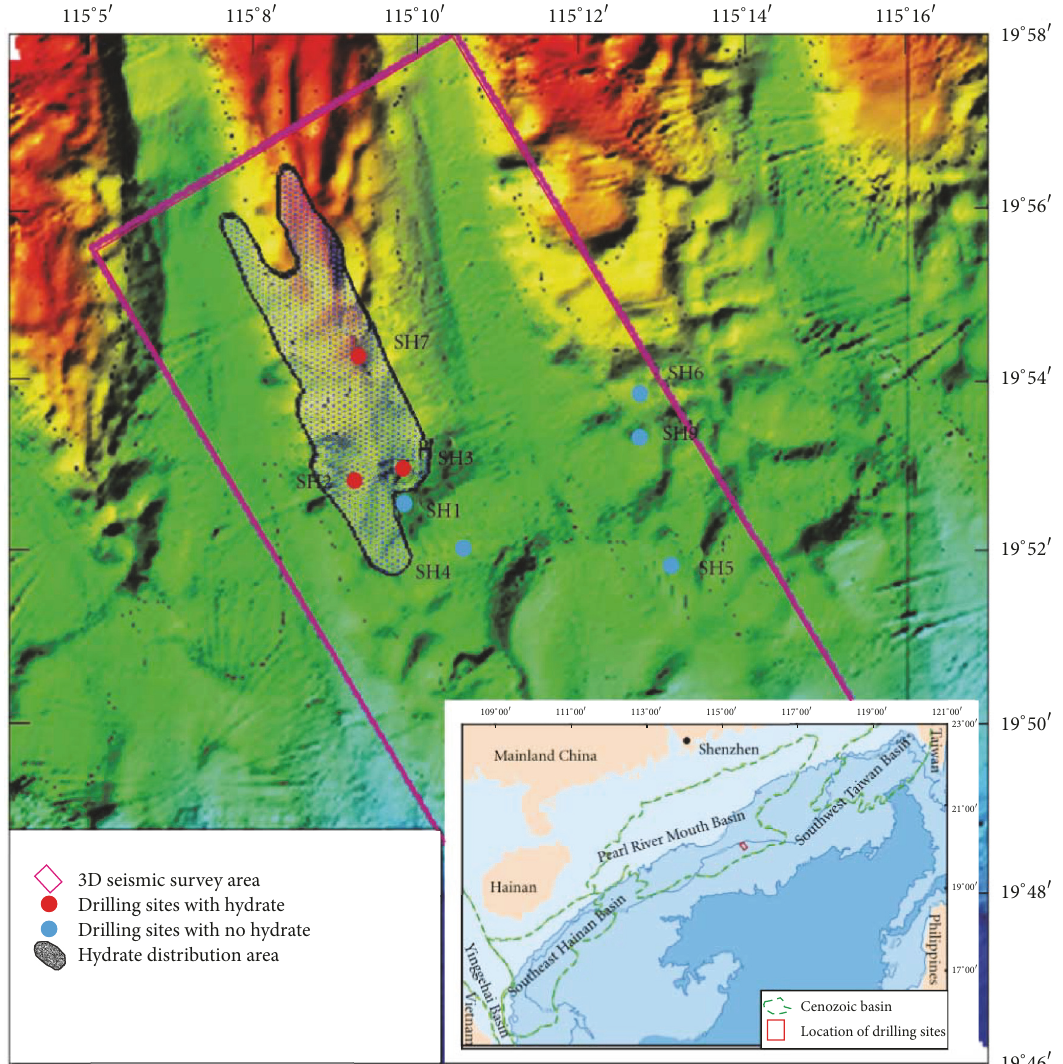
Figure 1: Location of study area, drilling sites, and the confirmed gas hydrate distribution in Shenhu area of the SCS [18].